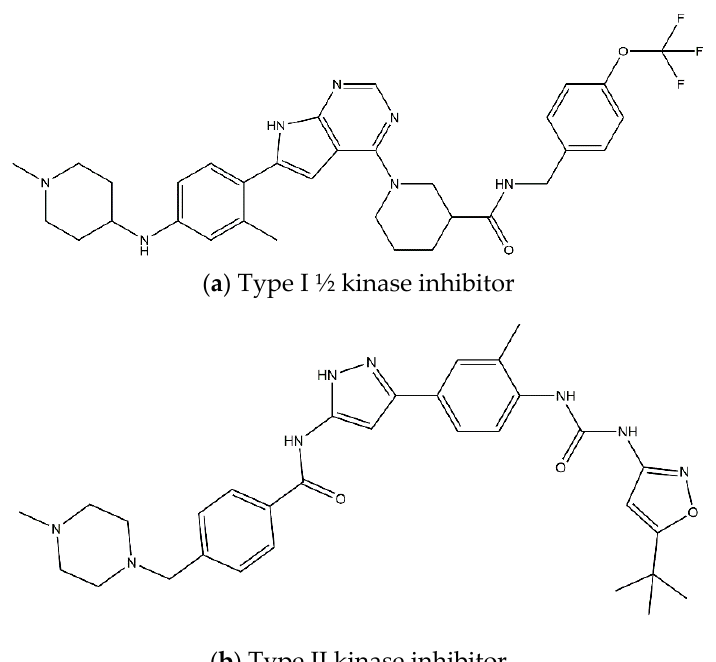
Figure 3. Structures of prominent candidates for a ( a ) type I ½ and a ( b ) type II anaplastic lym- phoma kinase inhibitor as presented in [7]. kinase inhibitor as presented in